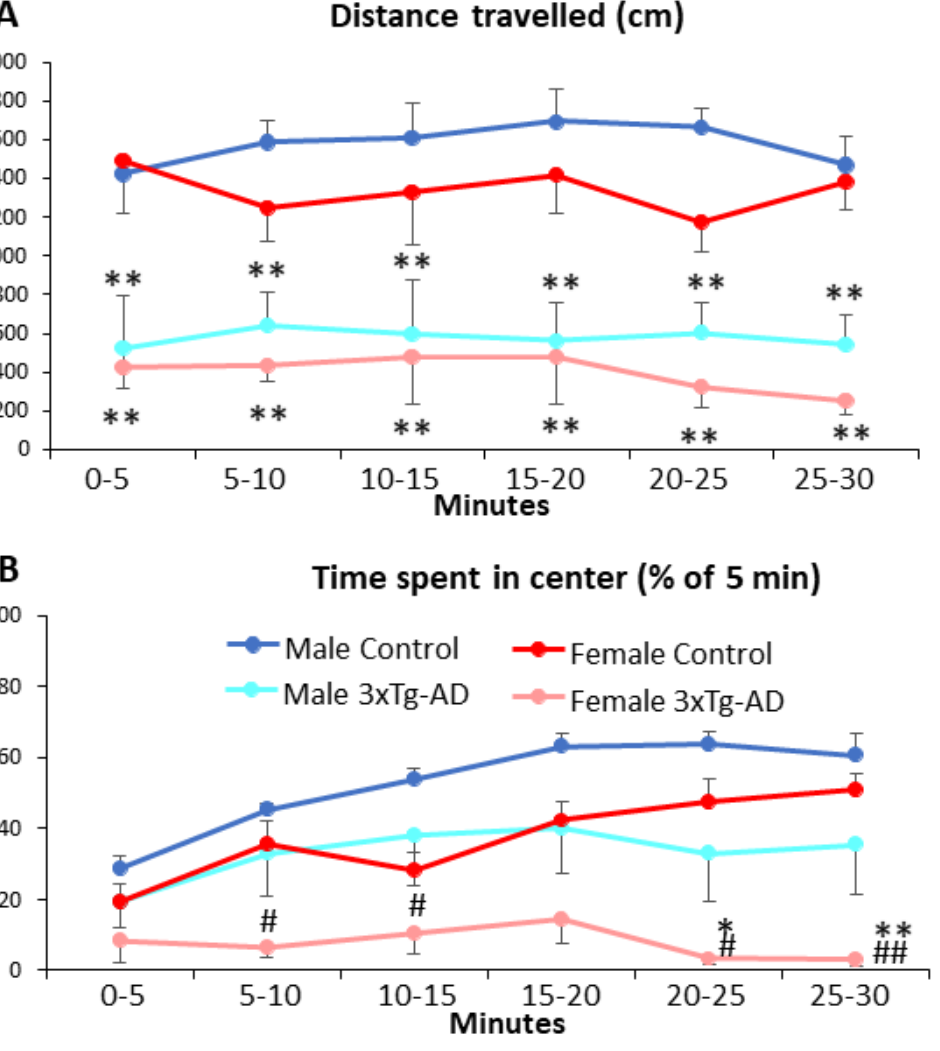
Figure 5. Open-field behavior during a 30 min observation period in 11-month-old animals. ( A ) Distance traveled in centimeters across 5 min time bins. The 3xTg-AD animals moved significantly less as their respective controls during the whole 30 min ( p < 0.01). There was no difference between sexes. ( B ) Percent of time spent in the center in 5 min time bins. The control animals spent more and more time in the center of the arena, suggesting a reduced anxiety over time ( p < 0.01), whereas the 3xTg-AD spent significantly less time in the center of the arena ( p < 0.01) without habituation over time (genotype × time: p < 0.01). Data are shown as the mean ± SEM. * p < 0.05, ** p < 0.01 vs. respective control; # p < 0.05, ## p < 0.01 vs. respective male.